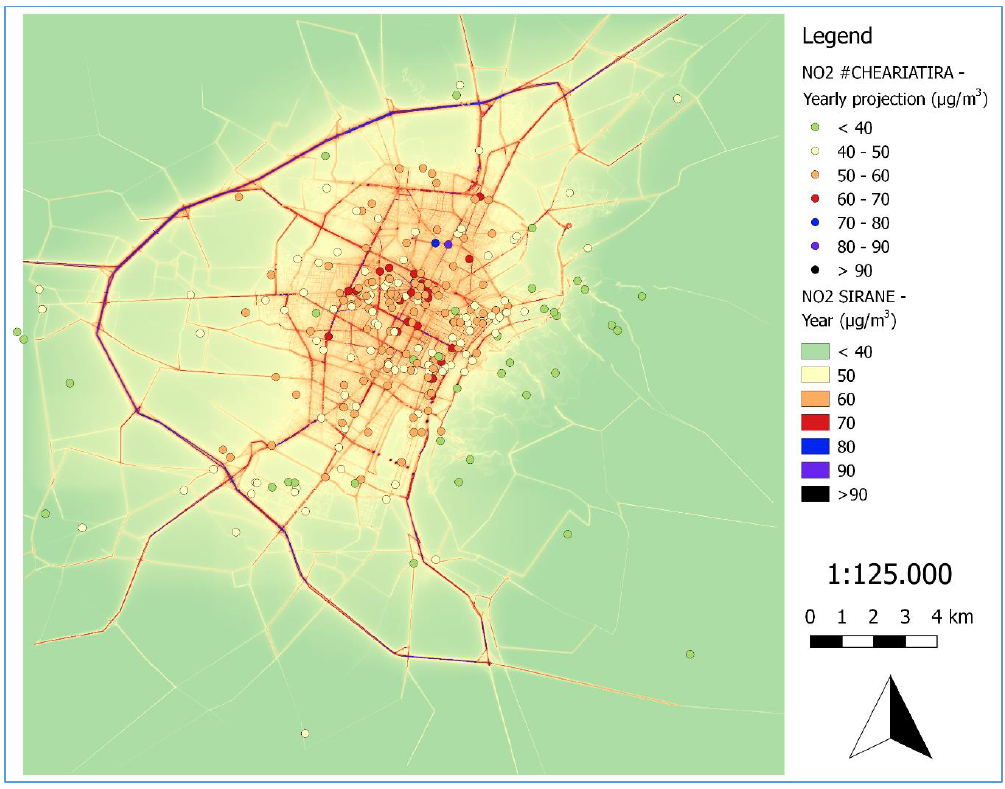
Figure 11. Map of average NO 2 concentrations modelled by SIRANE for 2019 with #CHEARIATIRA annual projection (elaboration by means of QGIS 2.18).